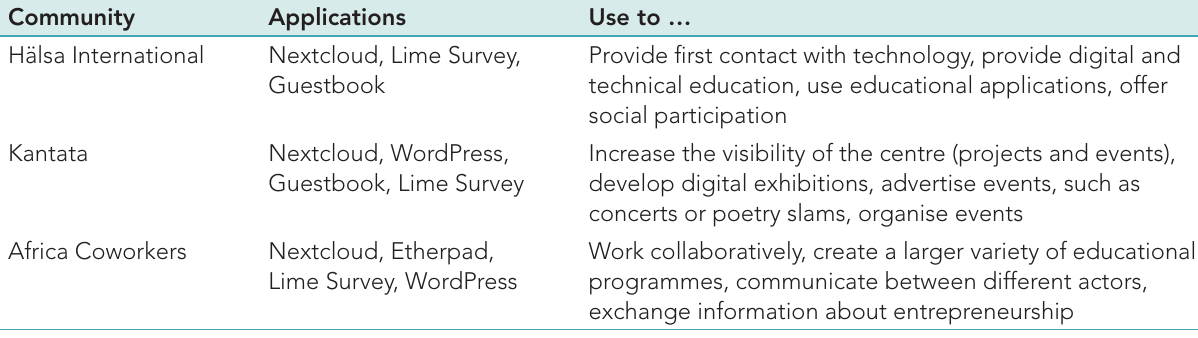
Table 3: How the communities are applying their local community networks, and which applications they are using (Source: Authors,